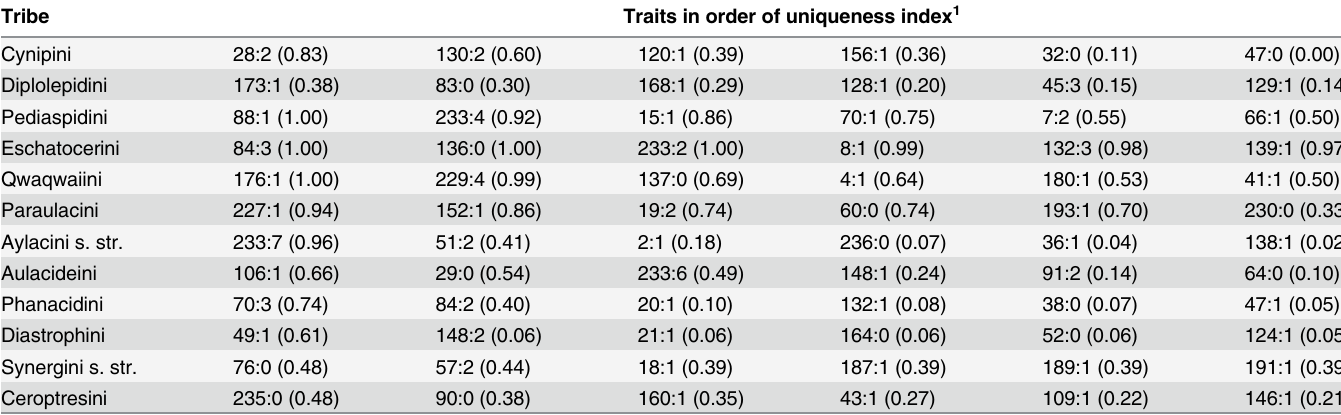
Table 4. Most unique traits of the 12 cynipid tribes recognized in this paper. Tribe Traits in order of uniqueness index